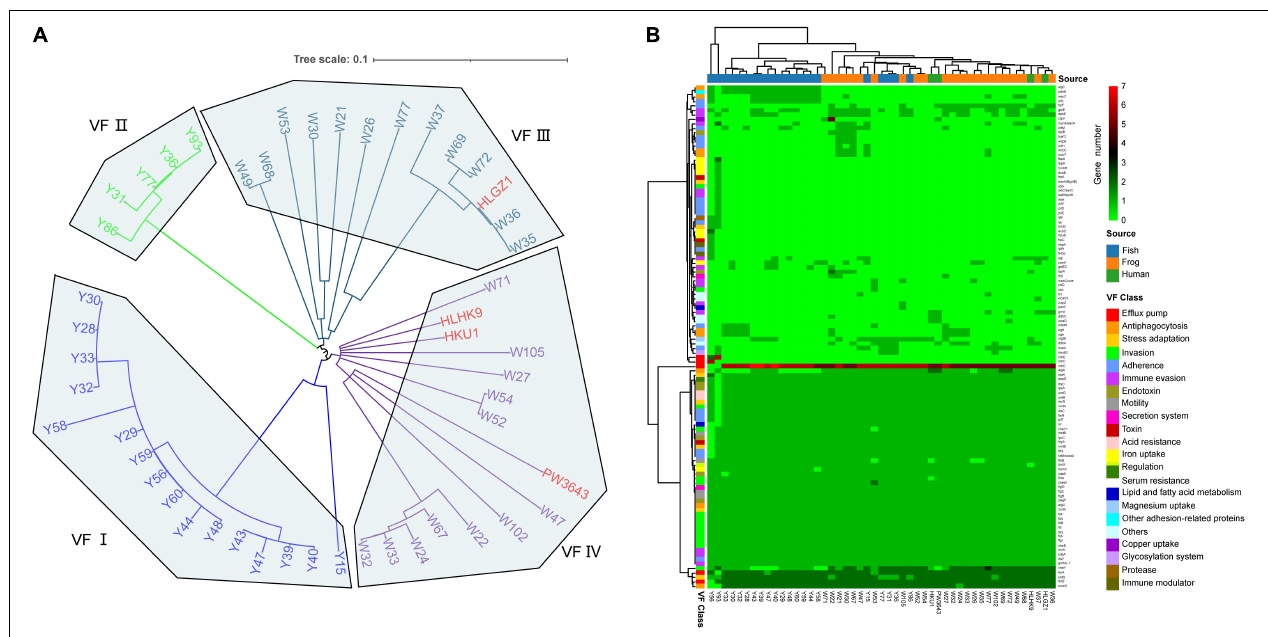
FIGURE 3 | Virulence factor profiles of 49 L. hongkongensis genomes. (A) Phylogenetic tree based on amino acid sequences of virulence factors using the Maximum Likelihood Method by parsnp. Human clinical strains were presented in strong pink. (B) Complex heatmap of predicted virulence genes in 49 genomes. Clustering was performed on row and column distances by ward. D2 method. The gene copy numbers, sample sources, and virulence factor classes were present indicated with different